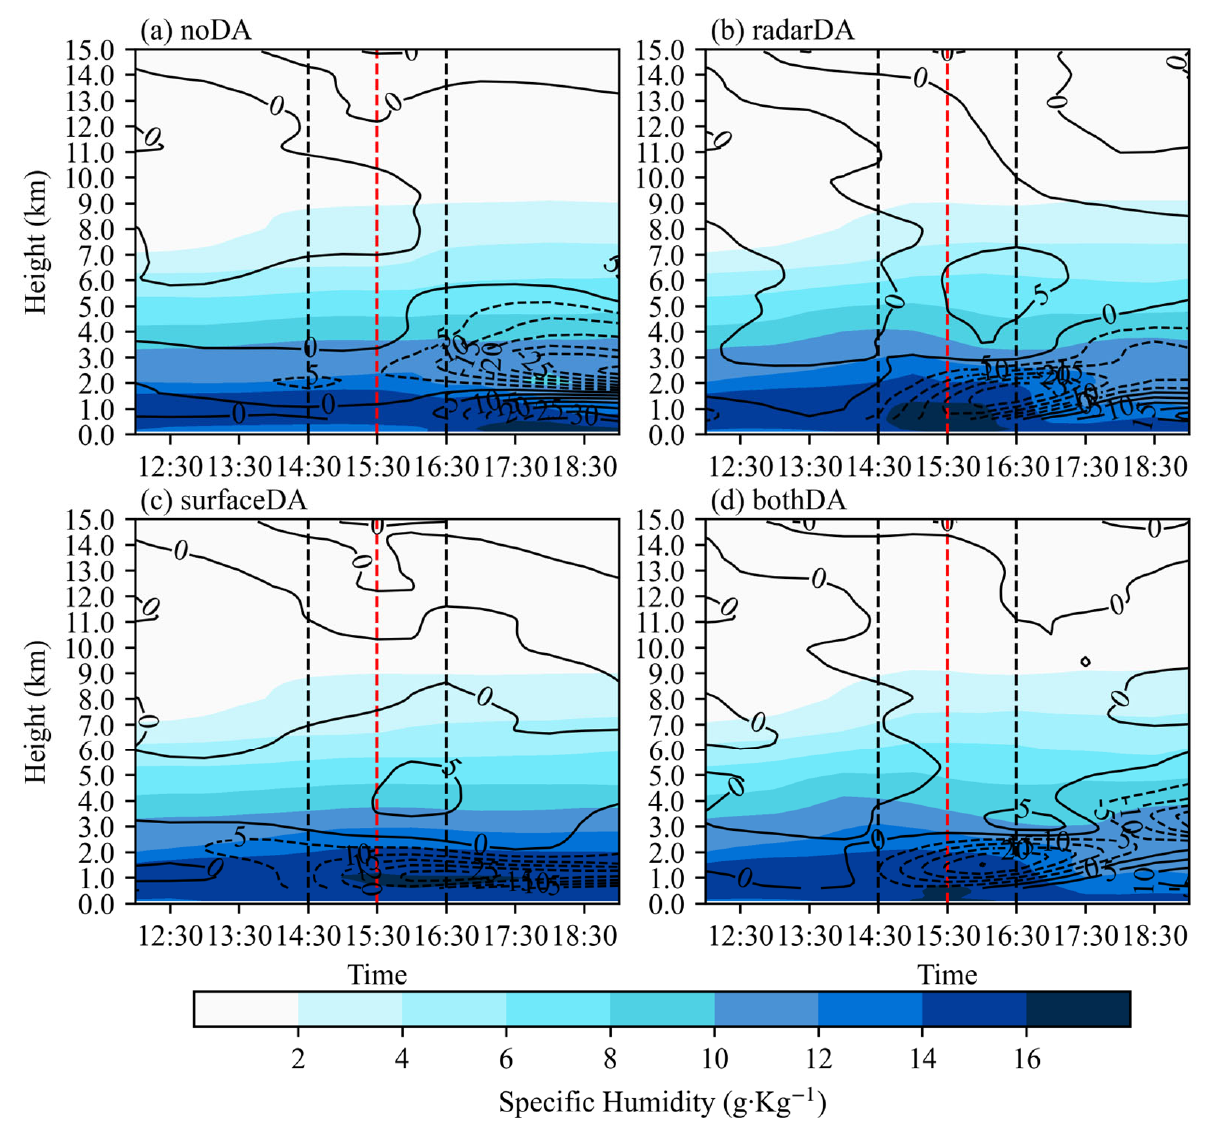
Figure 14. As in Figure 13 but for the specific humidity (shaded, units: g ∙ kg − 1 ) and the water vapor flux divergence (contour, units: 10 − 5 ∙ s − 1 ) for ( a ) noDA, ( b ) radarDA, ( c ) surfaceDA and ( d ) bothDA experiments.